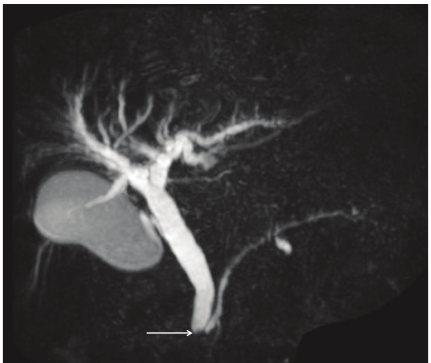
Figure 1: Magnetic resonance cholangiopancreatography showing dilated intrahepatic and extrahepatic bile ducts including the cystic duct and the gallbladder. The common bile duct measures 15mm in diameter with abrupt concentric stenosis in its lower third and a cut- off point located 20 mm distally to the duodenal ampulla (arrow). The pancreatic duct is depicted as normal.